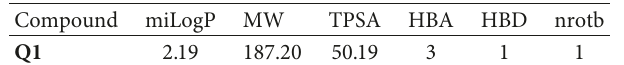
Figure 1: The parasite viability curve of (a) compound Q1 , (b) compound Q4 , (c) compound Q5 , and (d) compound Q12 . Table 3: Drug-likeness assessment by Molinspiration for com- pound Q1